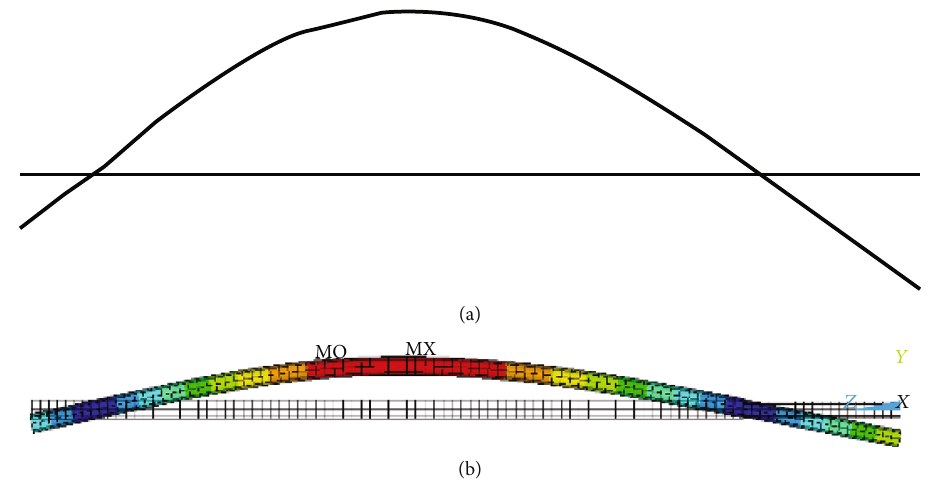
Figure 8: First-order mode shape of the rotor system. (a) Model established in this paper. (b) ANSYS beam model.